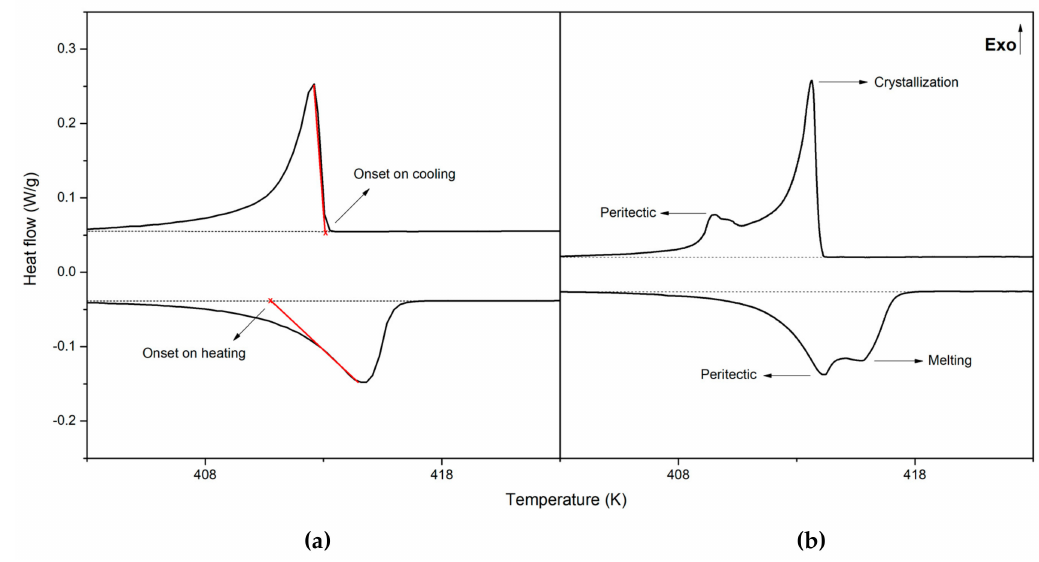
Figure 4. ( a ) Zoom of the DSC thermogram obtained for NPG-TRIS mixture with 0.7 mole fraction of TRIS showing the melting / crystallization process; ( b ) Zoom of the DSC thermogram obtained for NPG-TRIS mixture with 0.485 mole fraction of TRIS showing the peritectic transition and melting / crystallization